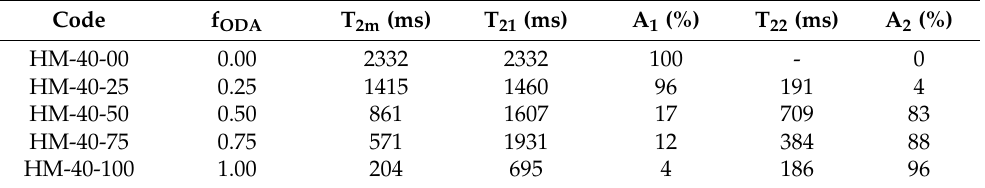
Table 3. Summary of the relaxation spectra (A i (%)—T 2i ) characterizing the studied hydrogels. T 2m indicates the average relaxation time (water relaxation time at 25 ◦ is ≈ 3000